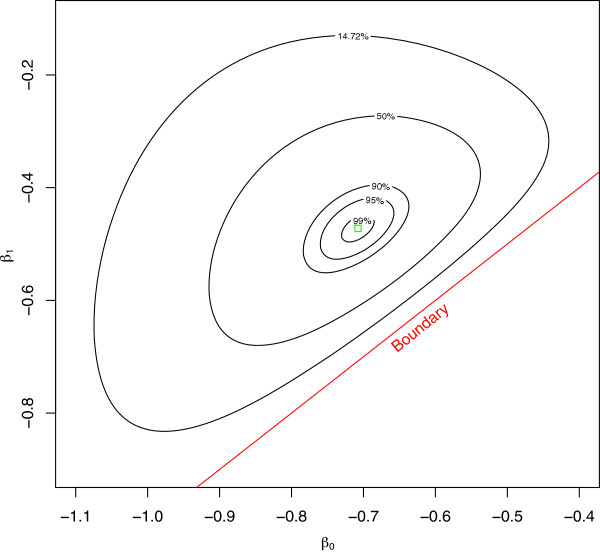
Log-relative likelihood contours for a log-binomial model with data in Table3.